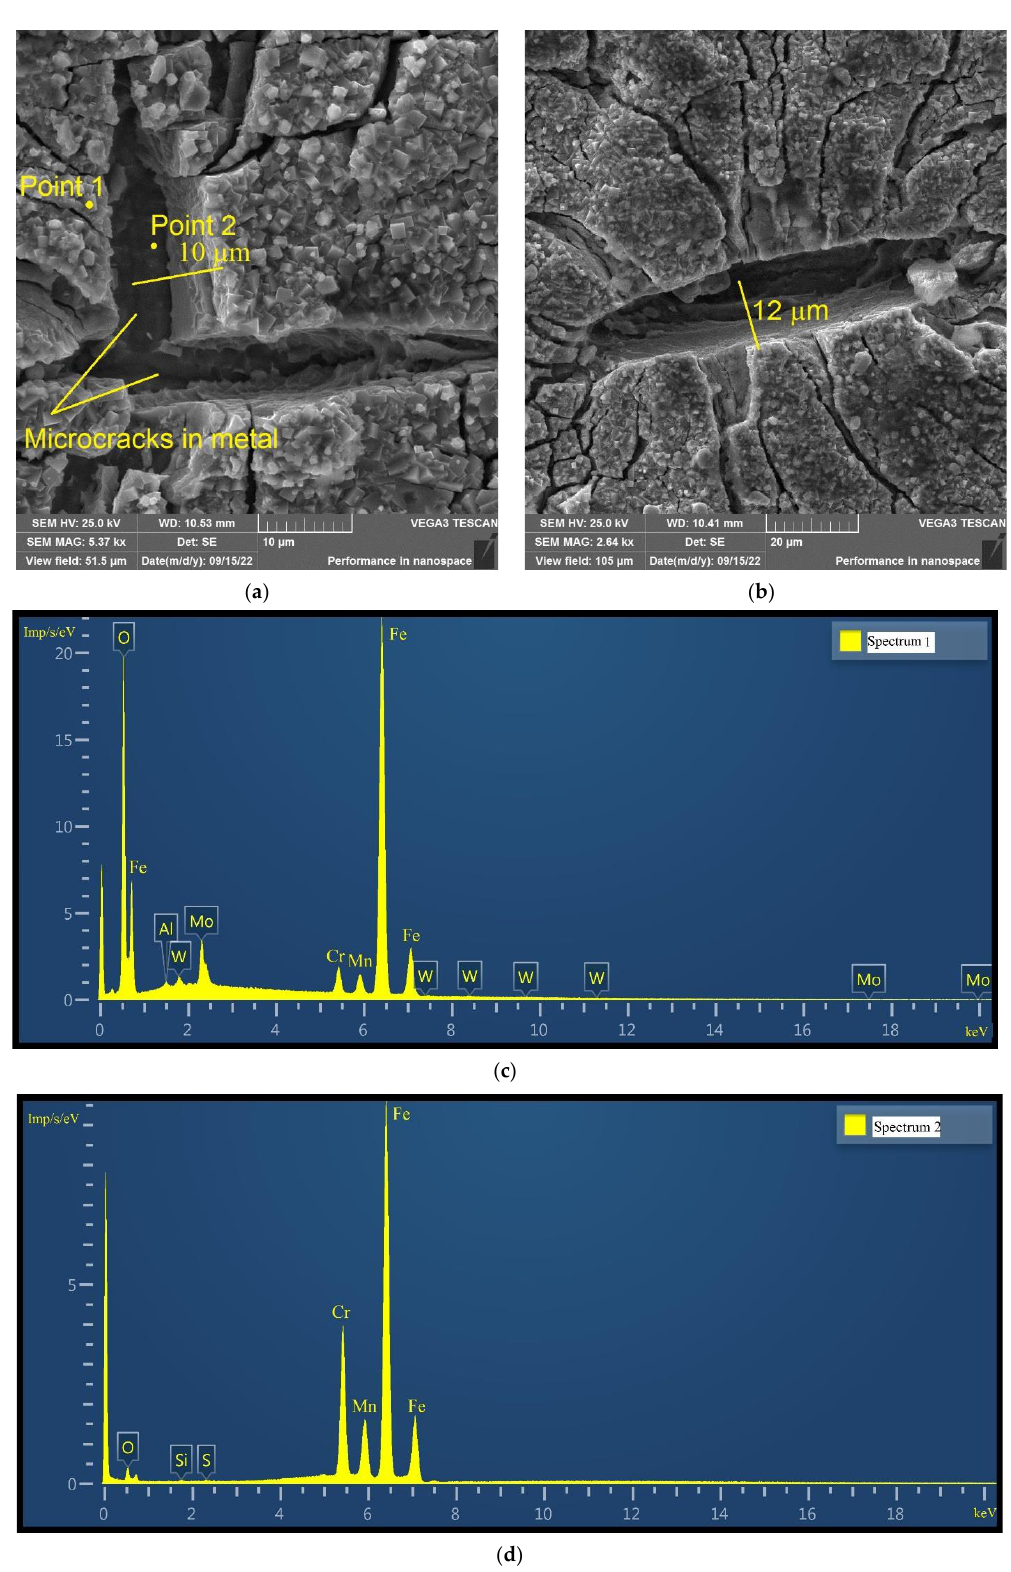
Figure 23. Surface of the disk specimen (T irr = 390 °C) after autoclave SCC test with a load value of 801N fractured at minus 140 °C. An overall view of broken-disk specimen ( a ). Fractured surface of broken-disk specimen( b ). An oxide layer of ~5 μm thick is observed. Under the oxide layer there is a microcleavage fracture of the metal (12Cr F/M steel) ( b ). EDS spectra for points 1 ( c ) and 2 ( d ).